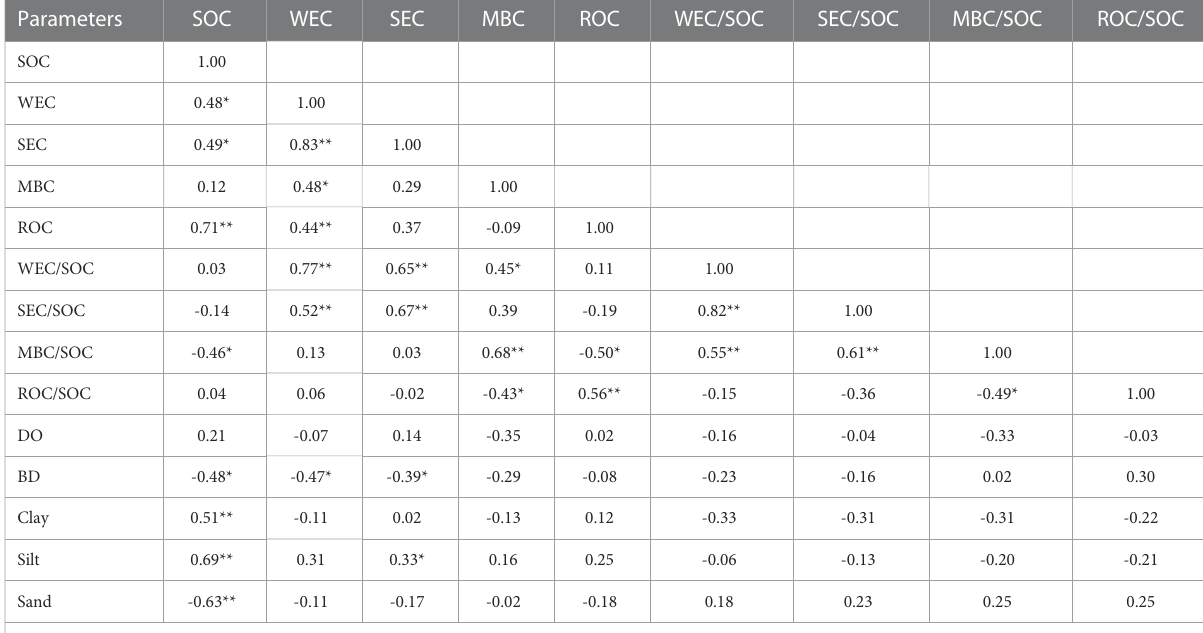
TABLE 1 The statistics of the relation of the main sedimentary parameters in this